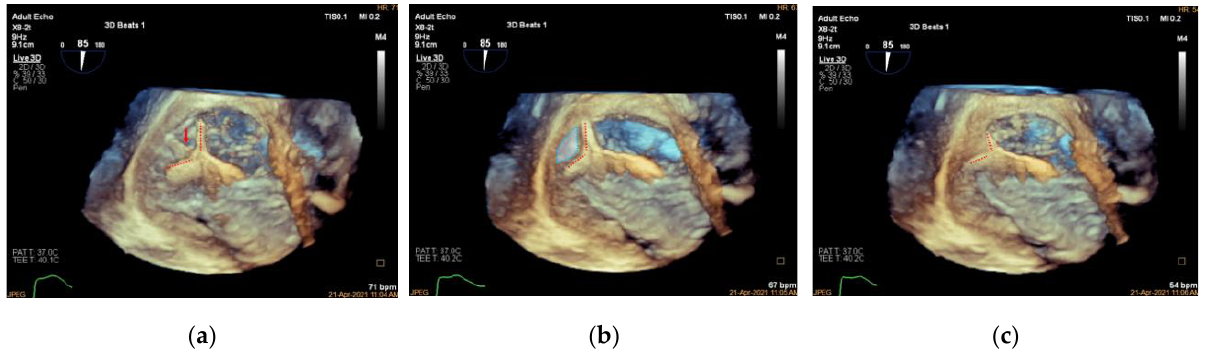
Figure 8. Clamping of annular tissue. ( a ): Three-dimensional work plane showing the clip arms aligned parallel to the tangent line with the tricuspid annulus (clip arms are shown as red dotted lines, anchor is indicated by a red arrow); ( b ): 3D work plane showing the target TA tissue is lifted and slowly clamped (blue area indicates lifted TA tissue); ( c ): 3D work plane showing the multilayer structure of the TA tissue and anchor clutched in the clip arms.